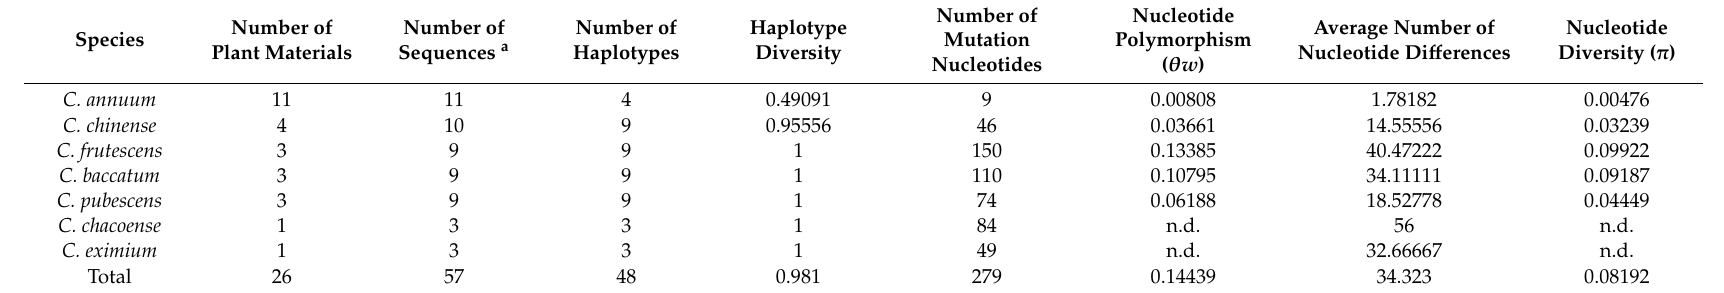
Table 2. Evaluation of genetic diversity within species based on